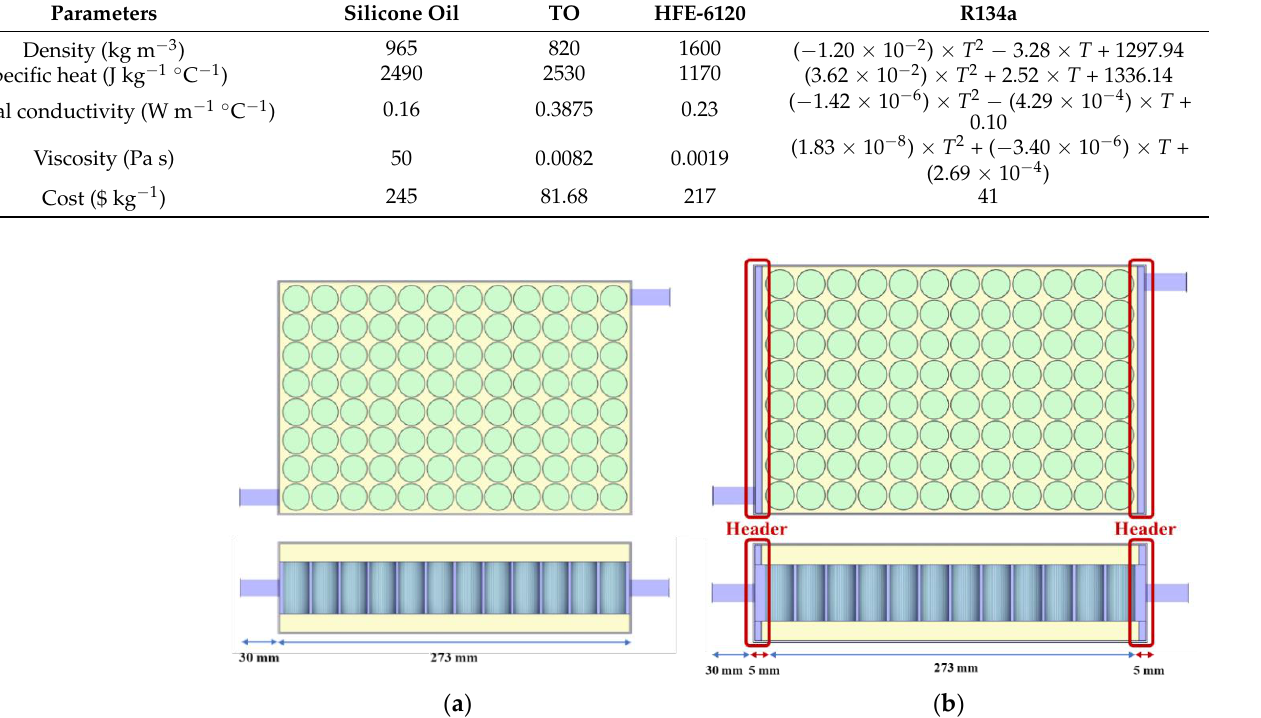
Table 2. Thermo-physical properties and cost of the working fluid [25,29,30,35 – 38]. Parameters